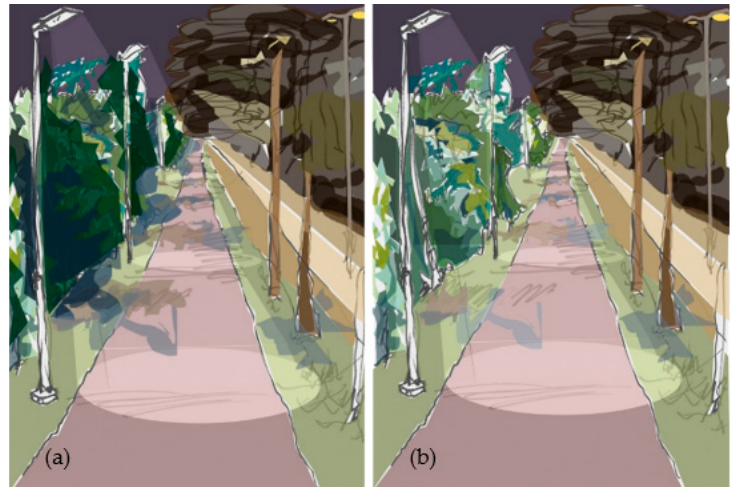
Commented [M3]: Please change the labels (A3(a), A3(b), A3(c), A3(d),) with (a,b,c,d).